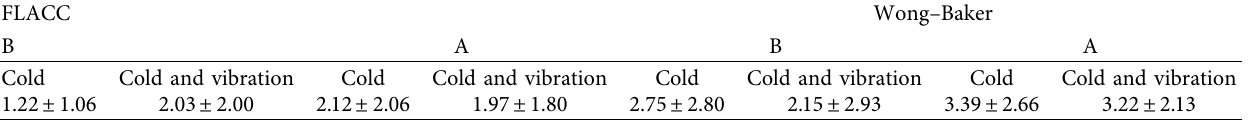
Table 1: Mean and standard deviation of Wong-Baker and FLACC scales in groups A and B.